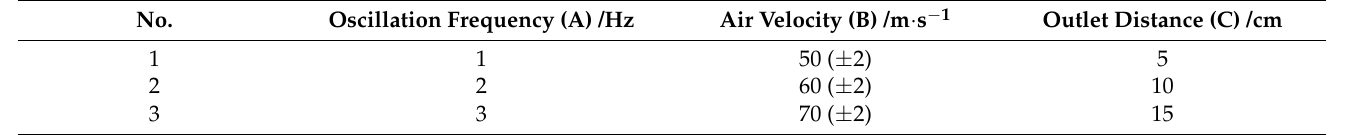
Table 3. Factors and levels of the orthogonal